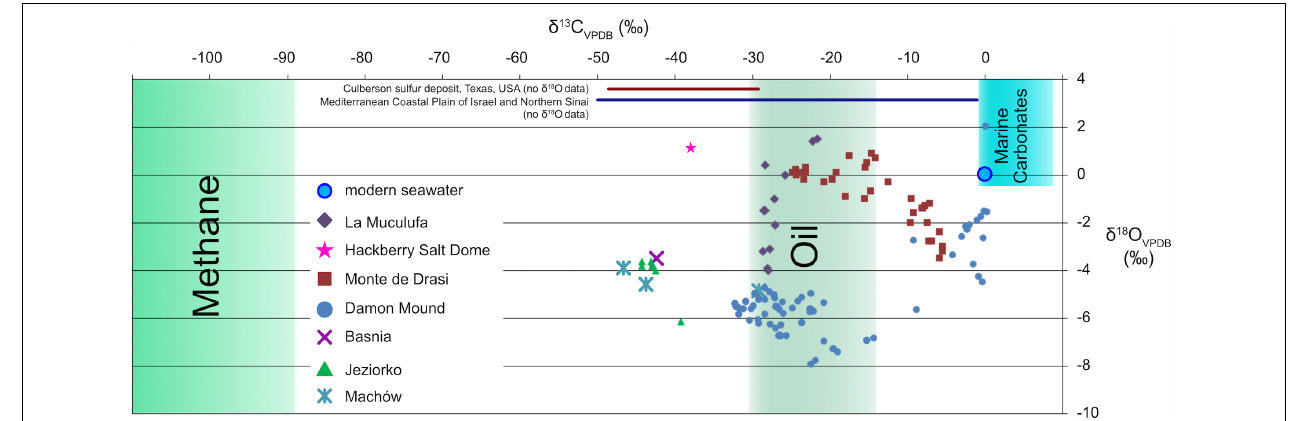
FIGURE 4 | Carbon isotopes systematics in epigenetic sulfur deposits. Compilation of carbon isotope data from carbonates from epigenetic native sulfur deposits. Thermogenic or biogenic methane is isotopically very light and may have contributed to the formation of carbonates at various sites, such as the south-eastern Mediterranean Coastal Plain of Israel and Northern Sinai (Nissenbaum, 1984), the Hackberry salt dome, Louisiana, United States (McManus and Hanor, 1993); the Carpathian Foredeep, Poland (Parafiniuk et al., 1994; Böttcher and Parafiniuk, 1998), Sicily, Italy (Ziegenbalg et al., 2012), and within stratiform native sulfur deposits in the Castile anhydrite in the northwestern and west-central Delaware Basin, United States (Kirkland, 2014). The carbon isotope composition of carbonates from Damon Mound (this study) fall almost entirely into the range between oil-derived carbon and carbonate from seawater, but a contribution from methane cannot be